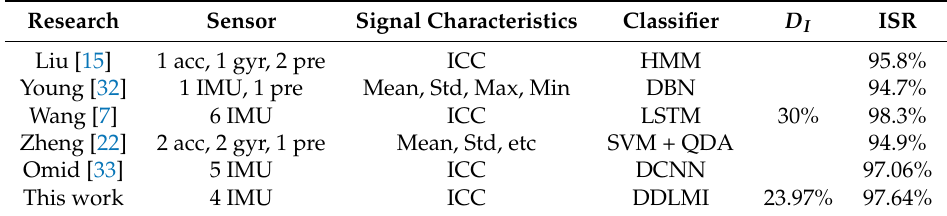
Table 3. Comparison of the methods and experimental results, where acc, gyr and pre represent accelerometer, gyroscope and pressure sensors, respectively.